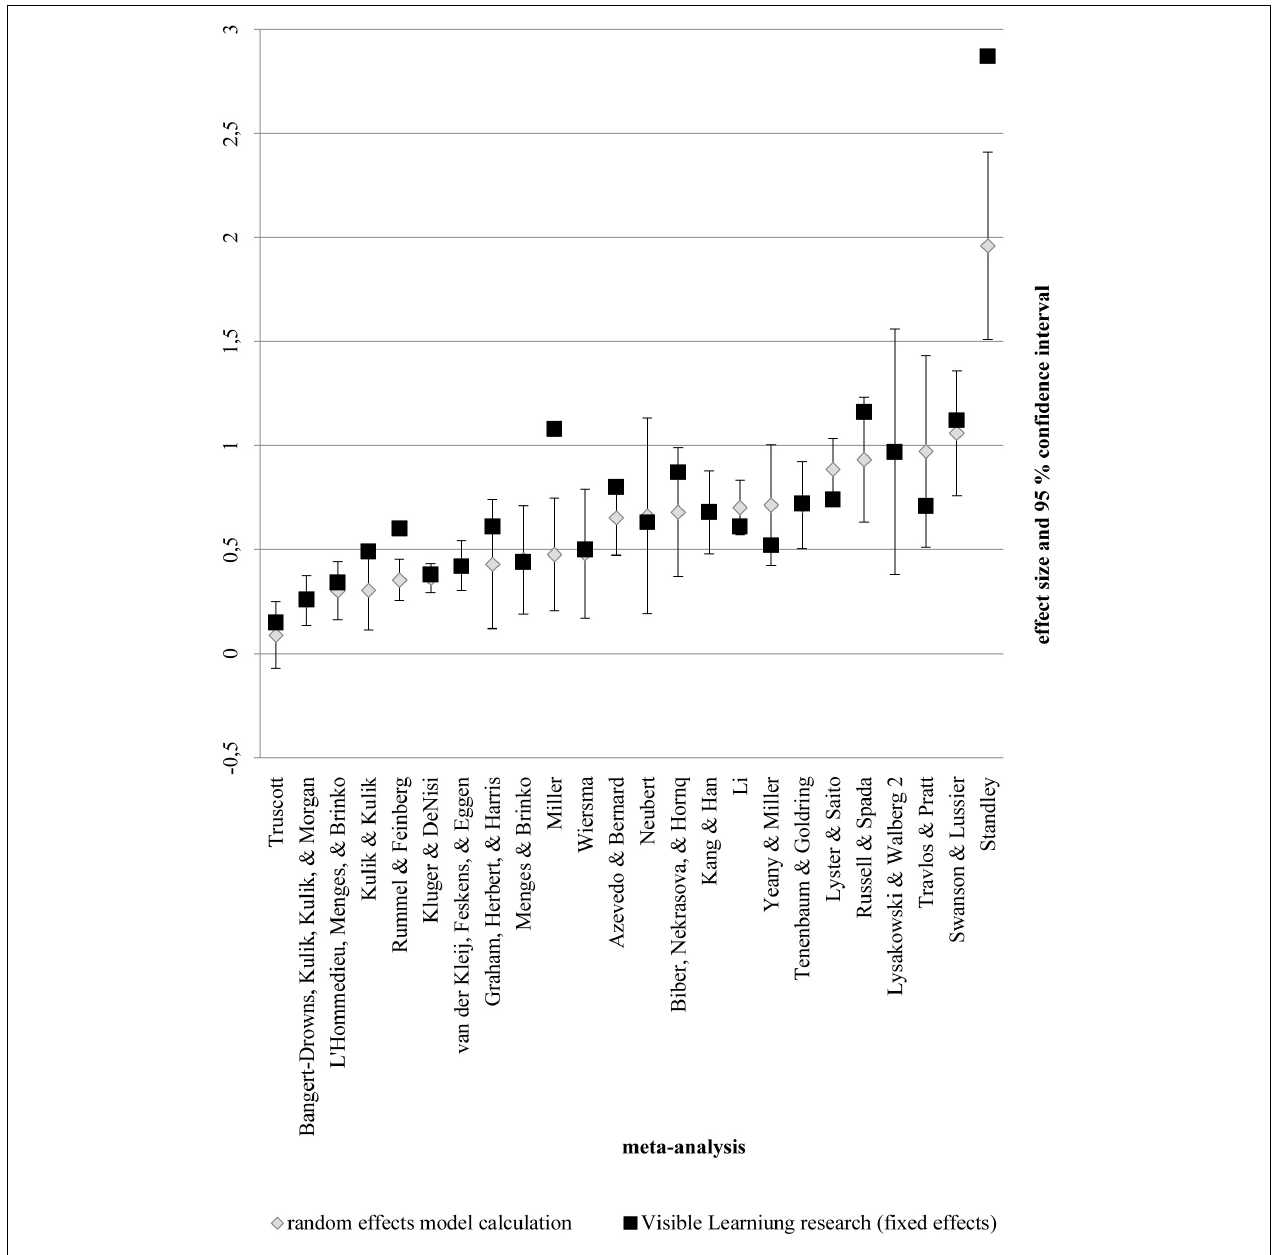
FIGURE 5 | Random-effects model calculation for the subsets of previous